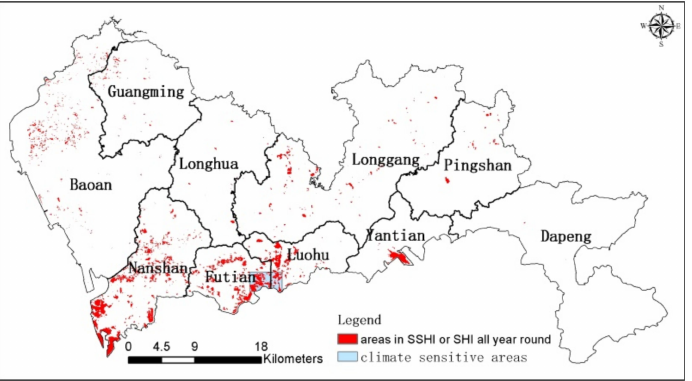
Figure 14. Climatic sensitive areas in Shenzhen. Table 5. Pearson correlation between SUHI and spatial morphological parameters. Spatial Morphological